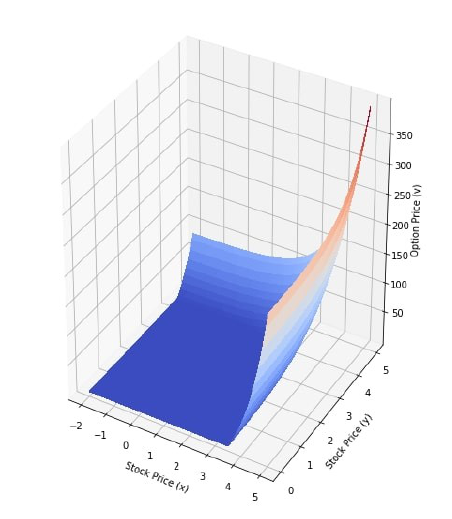
Figure 3. Values of the options for α = 0.75 and ρ = 1.